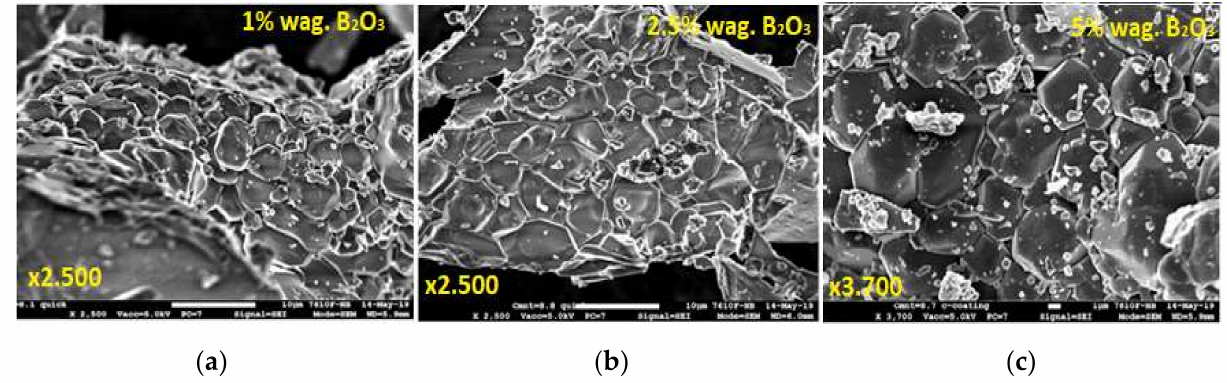
Figure 1. SEM images of CYMSSG: 2.5%Ce MPs, prepared using different amounts of B 2 O 3 flux agent: ( a ) 1 wt.%, ( b ) 2.5 wt.%, and ( c ) 5 wt.%.